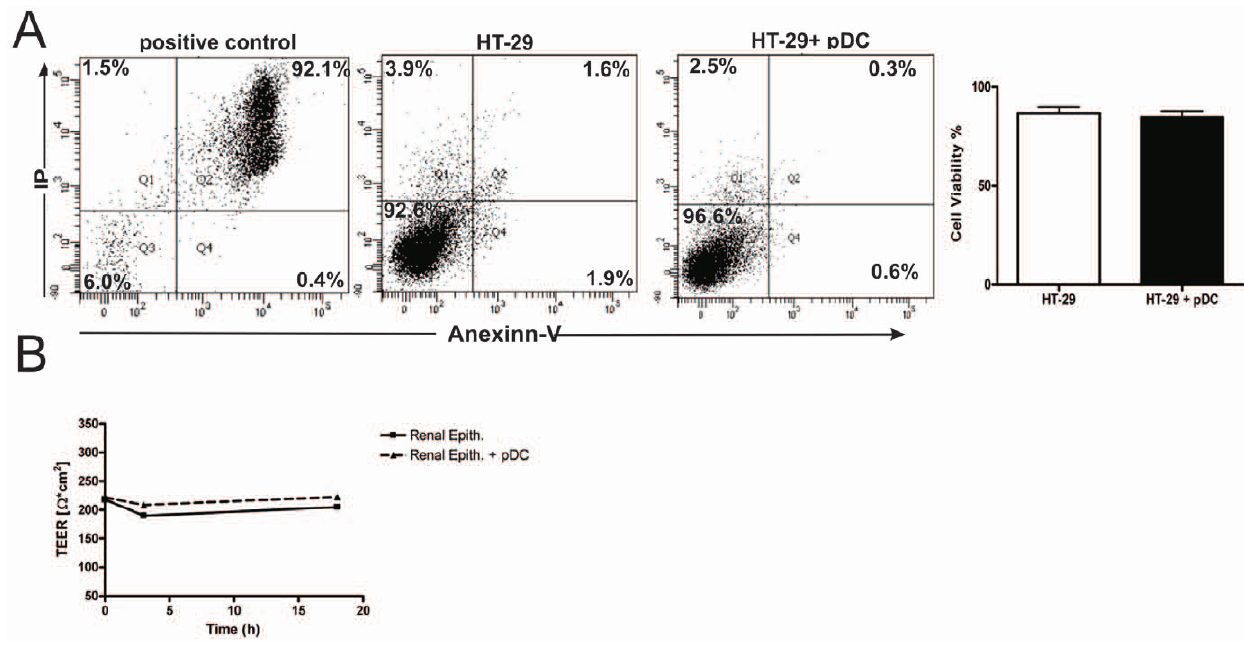
Figure 6. Plasmacytoid DCs do not affect the integrity of epithelial cells. ( A ) The epithelial cell line HT-29 was grown to confluence in 96 well flat bottom plates. Then, they were cultured in the absence or presence of pDCs (1 6 10 5 /200 m l) for 18 h, and the viability of epithelial cells was analyzed by flow cytometry using Annexin V and propidium iodide. Representative dot-plots are shown. Positive control represents epithelial cells culture for 18 hs in culture medium without fetal calf serum (protein-free medium). Graph bars show the percentages of epithelial cell viability for epithelial cells cultured alone or in the presence of pDCs. Results are the mean 6 SEM of 4 experiments performed in duplicate. ( B ) Primary human renal tubular epithelial cells (HRTEC) were grown to confluence on a polycarbonate filter (0.2 m m pore size) in the upper chamber of a 24-transwell plate. Then, epithelial cells were incubated for 18 h together with pDCs (2 6 10 5 ) in the upper chamber or in the absence of pDCs. At different time points the transepithelial electrical resistance (TEER) was measured, as described under Materials and Methods. A representative experiment (n=3) is shown.